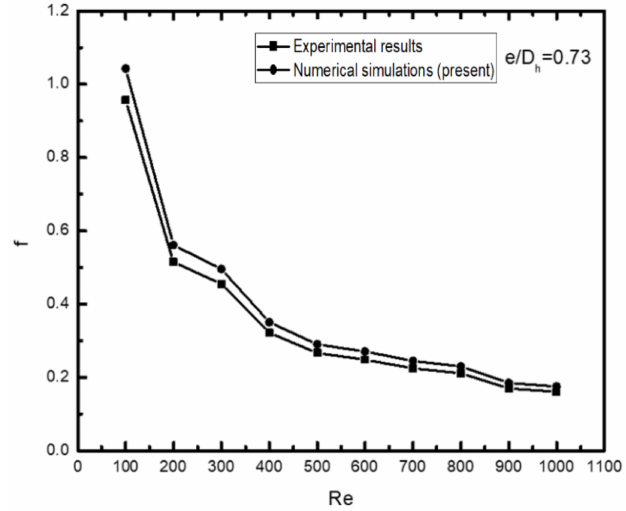
Figure 9. Friction factor ( f ) vs. Re for ribbed MCHS experimental [5] and